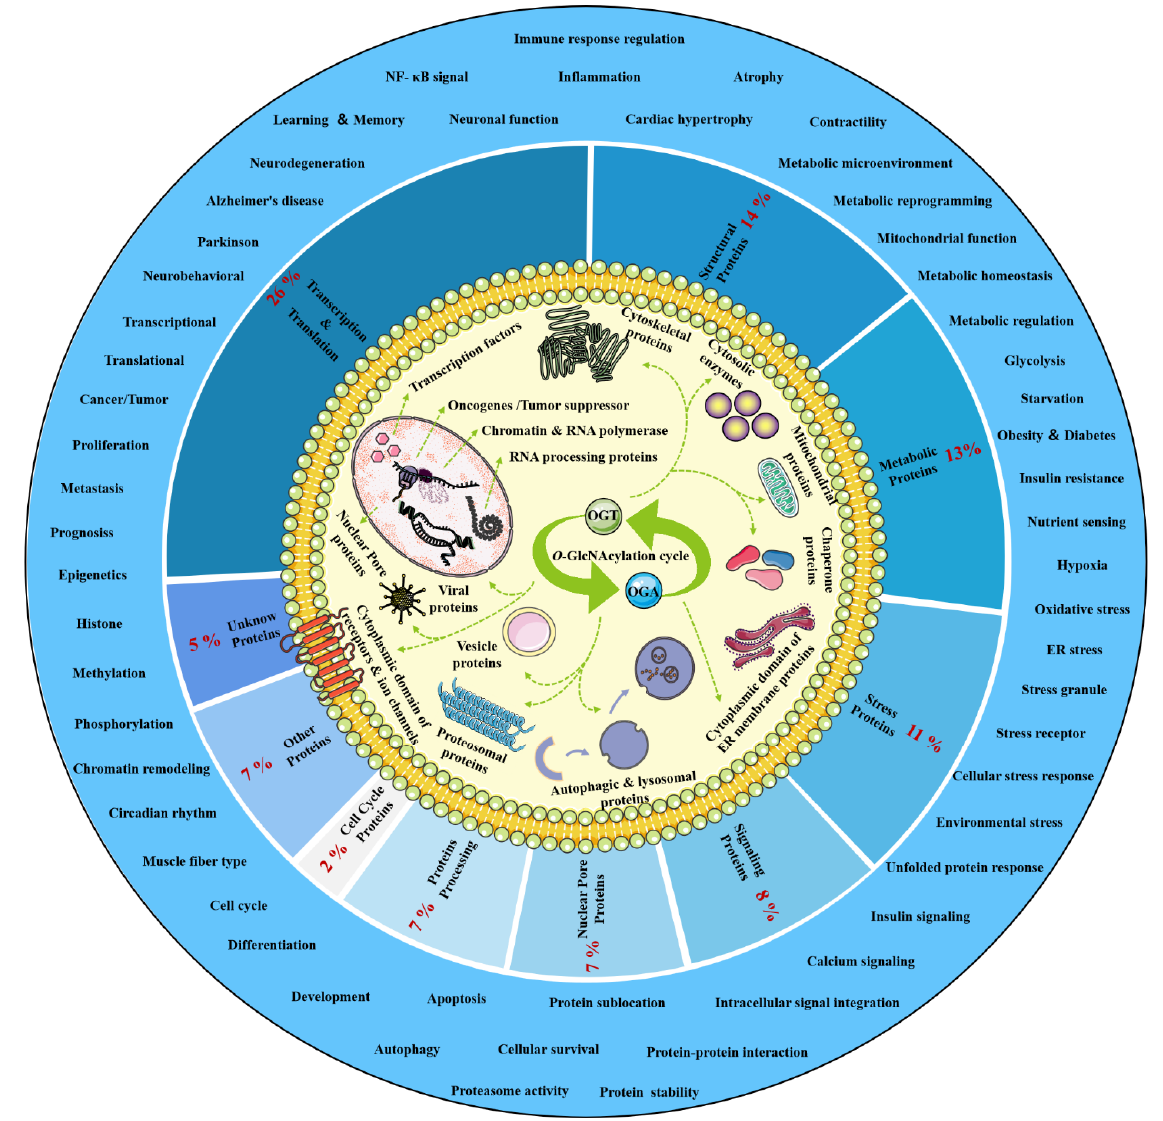
Figure 2. Classification, cellular distribution and physiological process of O ‐ GlcNAcylated proteins.